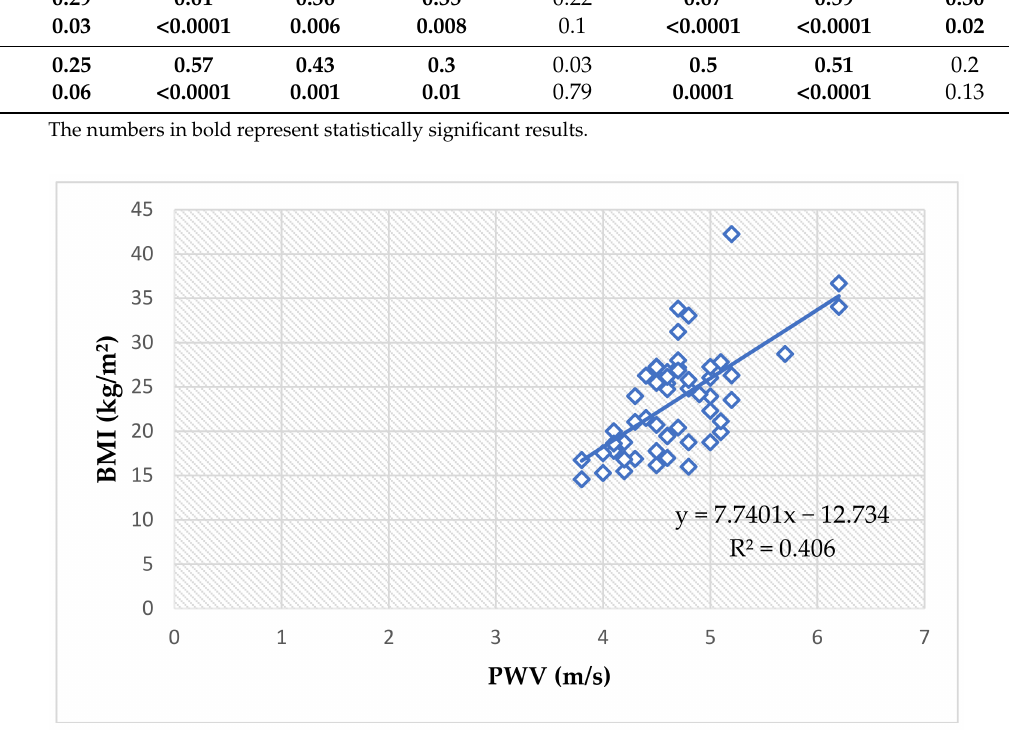
Figure 1. The correlation between PWV values and BMI values in all children (Spearman’s ρ = 0.58, p <